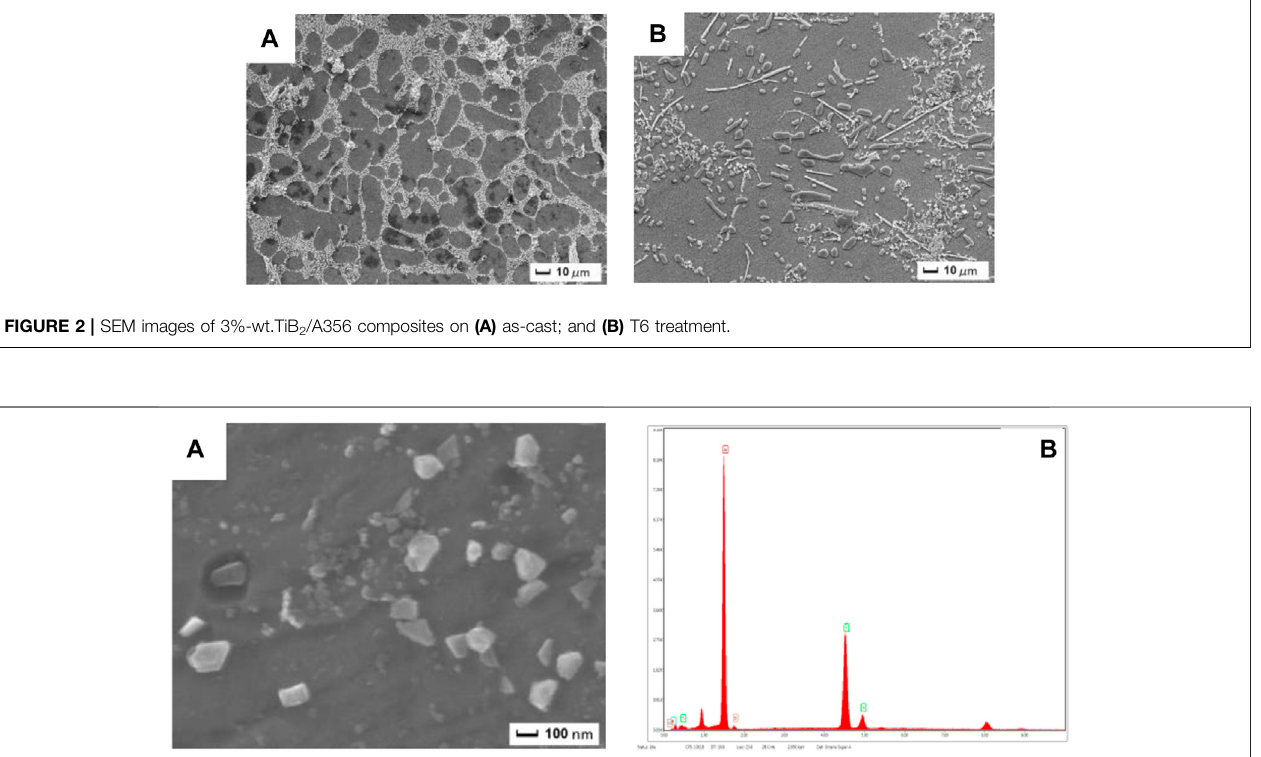
Frontiers in Materials |